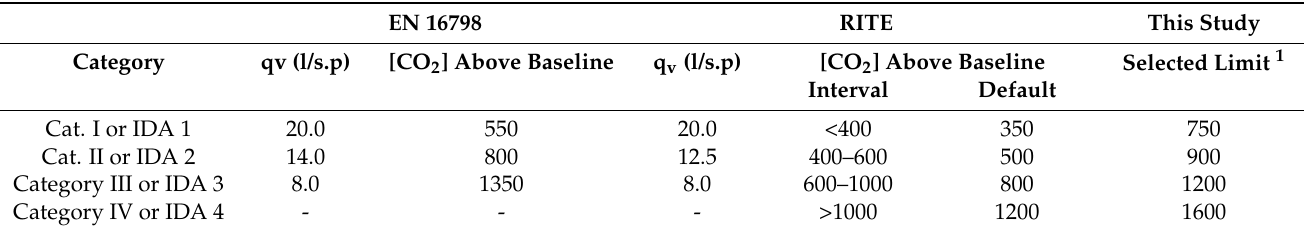
Table 2. Indoor air quality categories in the referenced